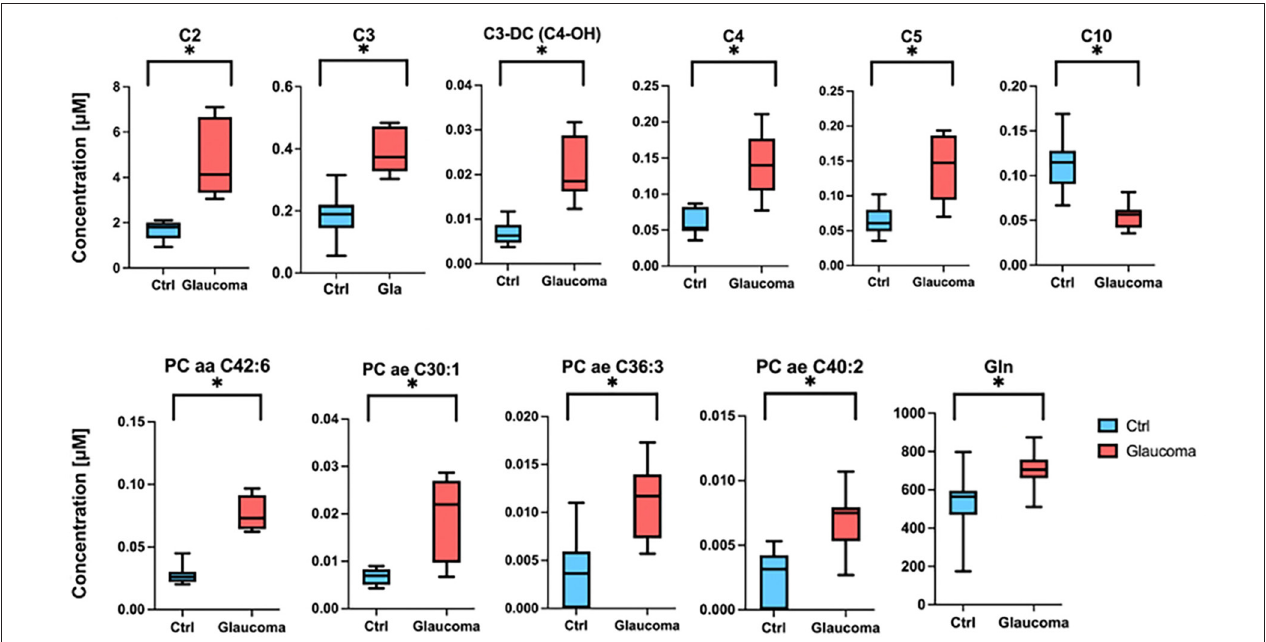
FIGURE 3 | Concentration of glutamine (Gln) and of acyl-carnitines and lysophosphatidylcholines in aqueous humor (AH) from healthy individuals and glaucoma patients. Data are shown as median in box-and-whisker plots (whiskers denote the highest and lowest value determined for each compound in each group, control or glaucoma). * p < 0.05.